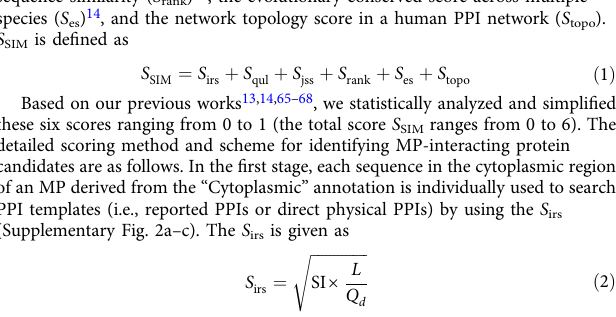
ffiffiffiffiffiffiffiffiffiffiffiffiffiffiffi